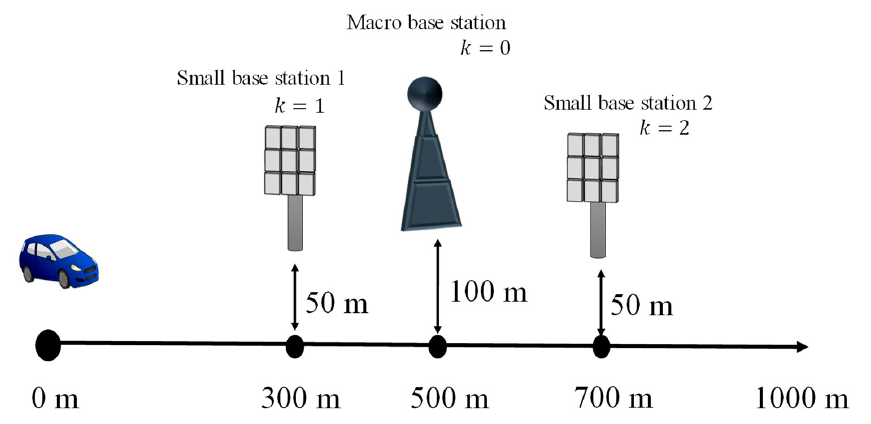
Figure 7. Simulation scenario.